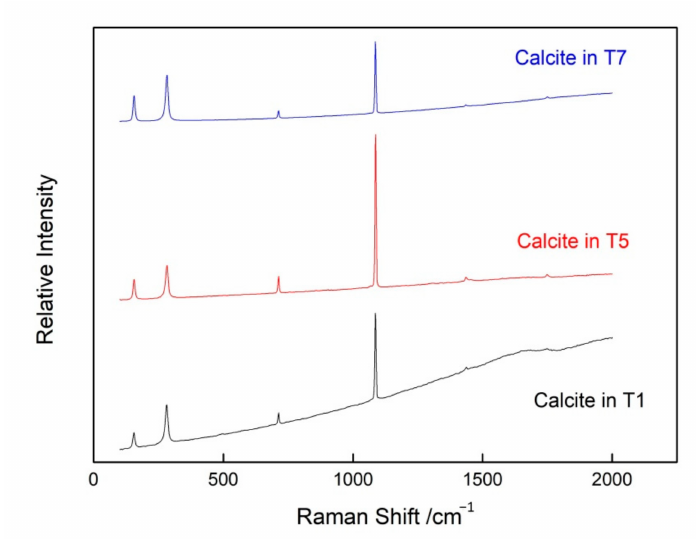
Figure 5. Micro-Raman spectra of calcite inclusions in tanzanite samples T1, T5 and T7.